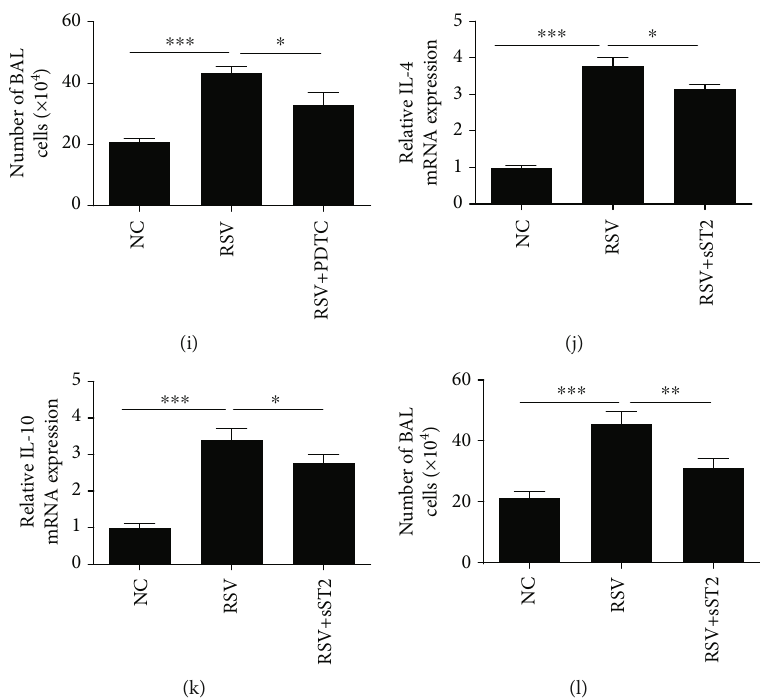
Figure 2: NF- κ B/IL-33/ST2 axis is mediated the Th2 cytokine levels and BAL cell number induced by RSV. (a) Western blot analysis was performed to examine the abundance of p-I κ Ba, ST2, p-p65, and p-p50. (b, c) RT-PCR analysis was used to examine the mRNA expression of Th2-related cytokines IL-4 and IL-10 after IL-33 antibody treatment. (d) In fl ammatory cell number of bronchoalveolar lavage fl uid after IL-33 antibody treatment. (e) ST2 protein abundance was examined by western blot analysis. (f) The IL-33 mRNA expression in lung tissues was detected by RT-PCR. (g, h) RT-PCR analysis was used to examine the mRNA expression of Th2-related cytokines IL-4 and IL-10 after PDTC treatment. (i) In fl ammatory cell number of bronchoalveolar lavage fl uid after PDTC treatment. (j, k) PCR analysis was used to examine the mRNA expression of Th2-related cytokines IL-4 and IL-10 after sST2 treatment. (l) In fl ammatory cell number of bronchoalveolar lavage fl uid after sST2 treatment. All data were expressed as the mean ± SD ( n = 3 ). Each value of ∗ p < 0 : 05 , ∗∗ p < 0 : 01 , and ∗∗∗ p < 0 : 001 was considered to be signi fi cant di ff